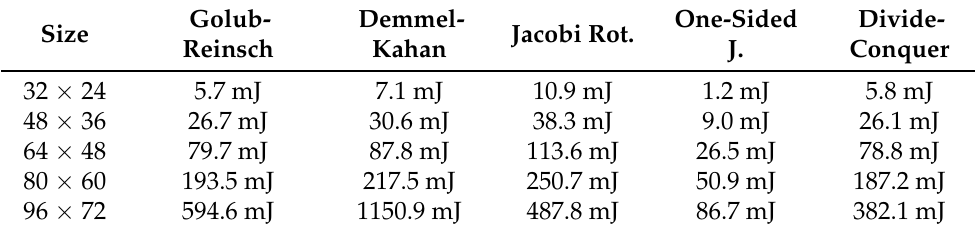
Table 7. Energy consumption of SVD algorithms on Cortex-M4F.